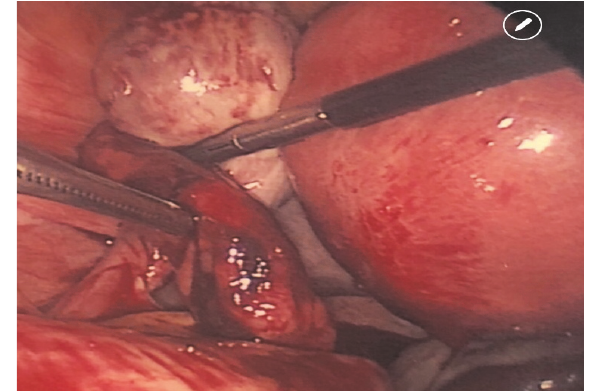
Figure 1: TVUS imageof rightadnexa with corpus lutealcyst versus ectopic gestation.